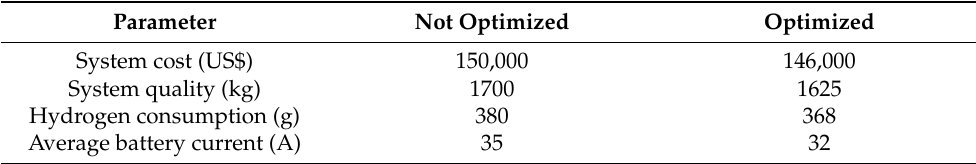
Table 8. Comparison of the simulation results before and after the